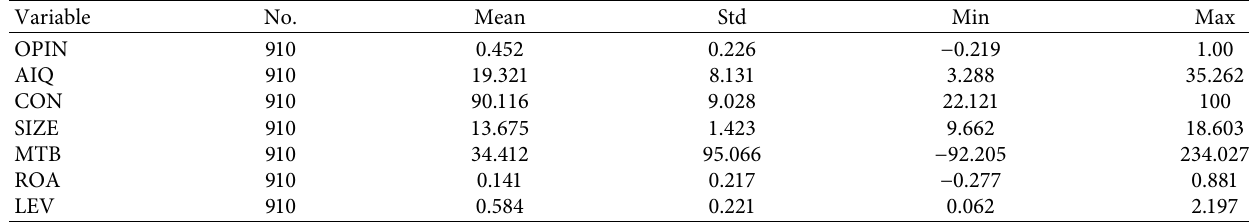
Table 2: Descriptive statistics of research variables.